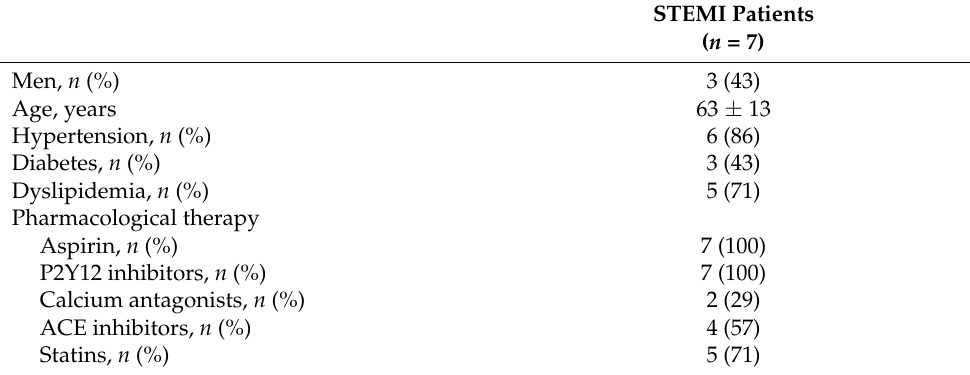
Table 1. Clinical and demographic characteristics of the enrolled STEMI